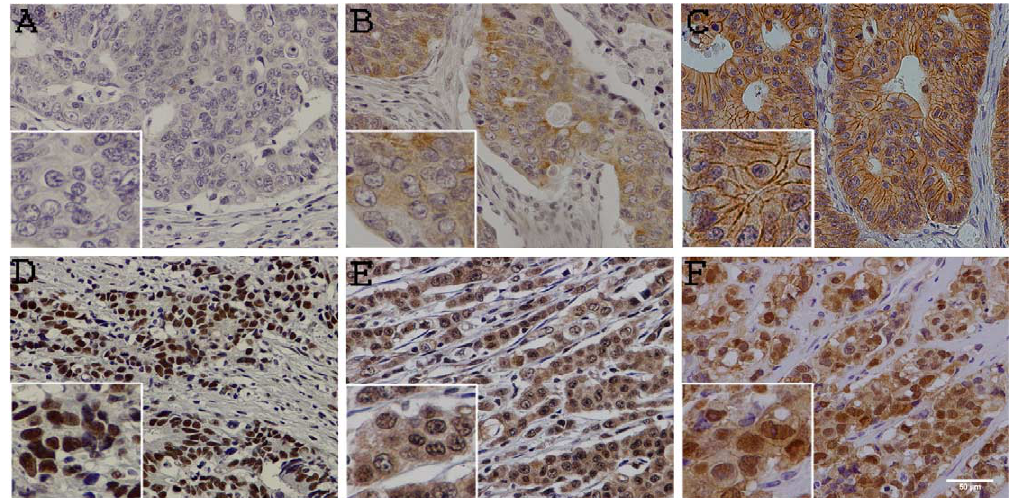
Fig. 5. Nuclear SnoN and Ski expression correlates with activation of β -catenin in colon cancer. (A–C) Adjacent sections of a colon carcinoma showing negative nuclear expression of SnoN (A) and Ski (B) and normal membranous expression of β -catenin (C). (D–F) Adjacent sections of a tumor showing intense nuclear localization of SnoN (D), Ski (E) and β -catenin (F) (400 × magnification). Inserts in lower left corner show the subcellular localization of immunostaining in each case at higher magnification (2 × original objects). Bar corresponds to 50